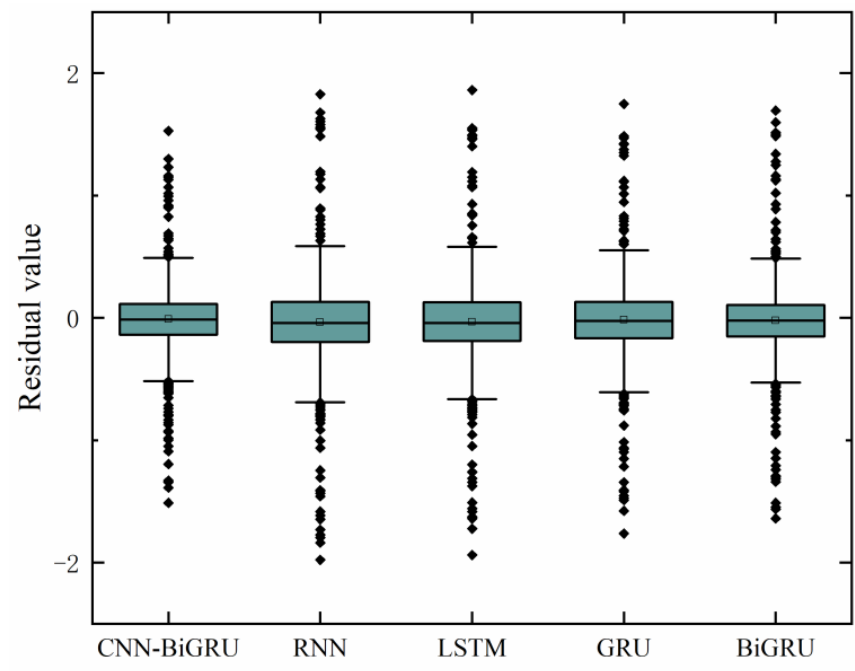
Figure 8. Prediction result residual value box